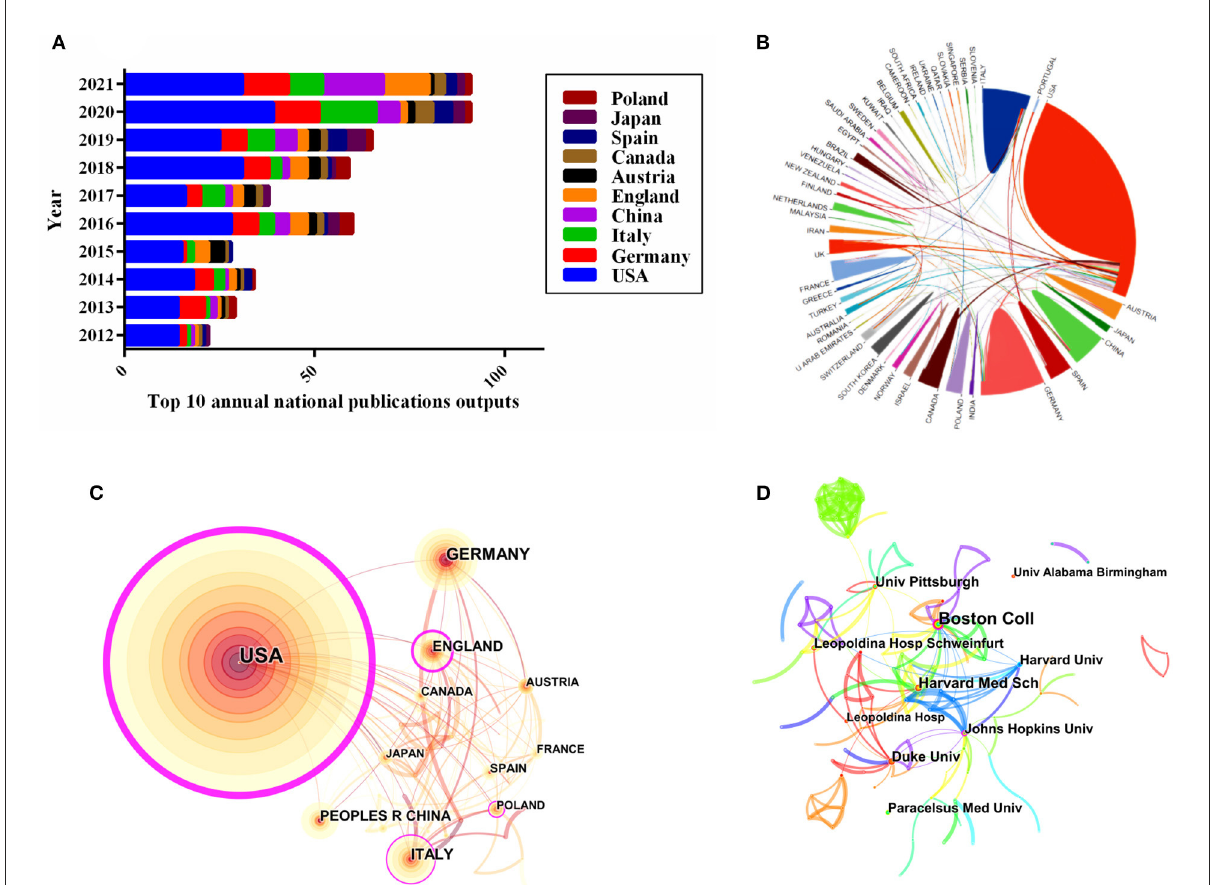
FIGURE3 Visualization map of countries/regions and institutions in the field of KD on cancer from 2012 to 2021. (A) Number of annual publications and growth trends of the top 10 countries/regions. (B) The international network cooperation between the countries, exported the results from the website of bibliometrics (http://bibliometric.com). (C) Citespace network map of KD in cancer research involving 57 countries. (D) Collaboration network analysis of institutions.